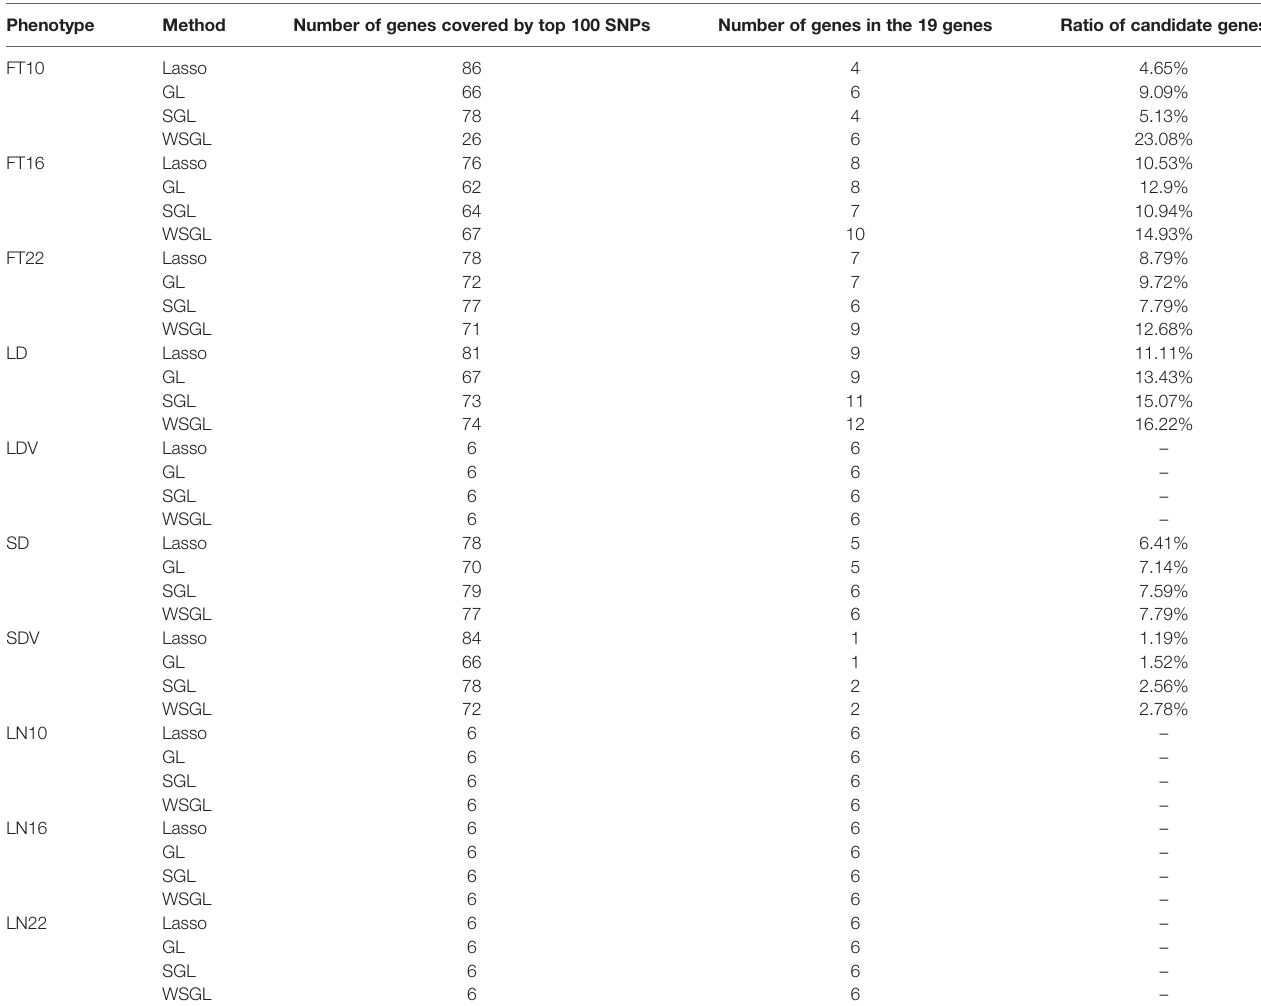
TABLE 2 | Summary of four methods associations found in real